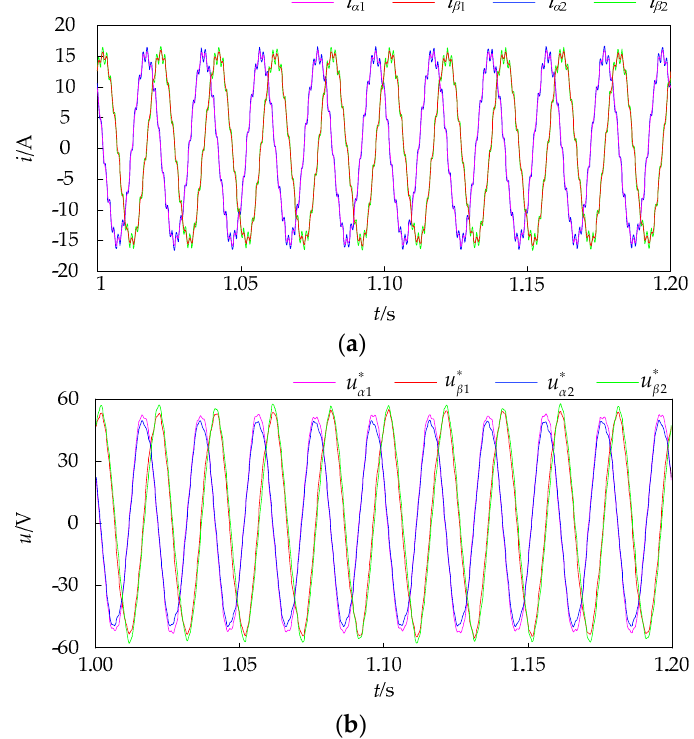
i Figure 16. The curve of experimental result: ( a ) i α 1 , i β 1 and i α 2 , i β 2 ; ( b ) u ∗ α 1 , u ∗ β 1 and u ∗ α 2 , u ∗ β 2 1 α